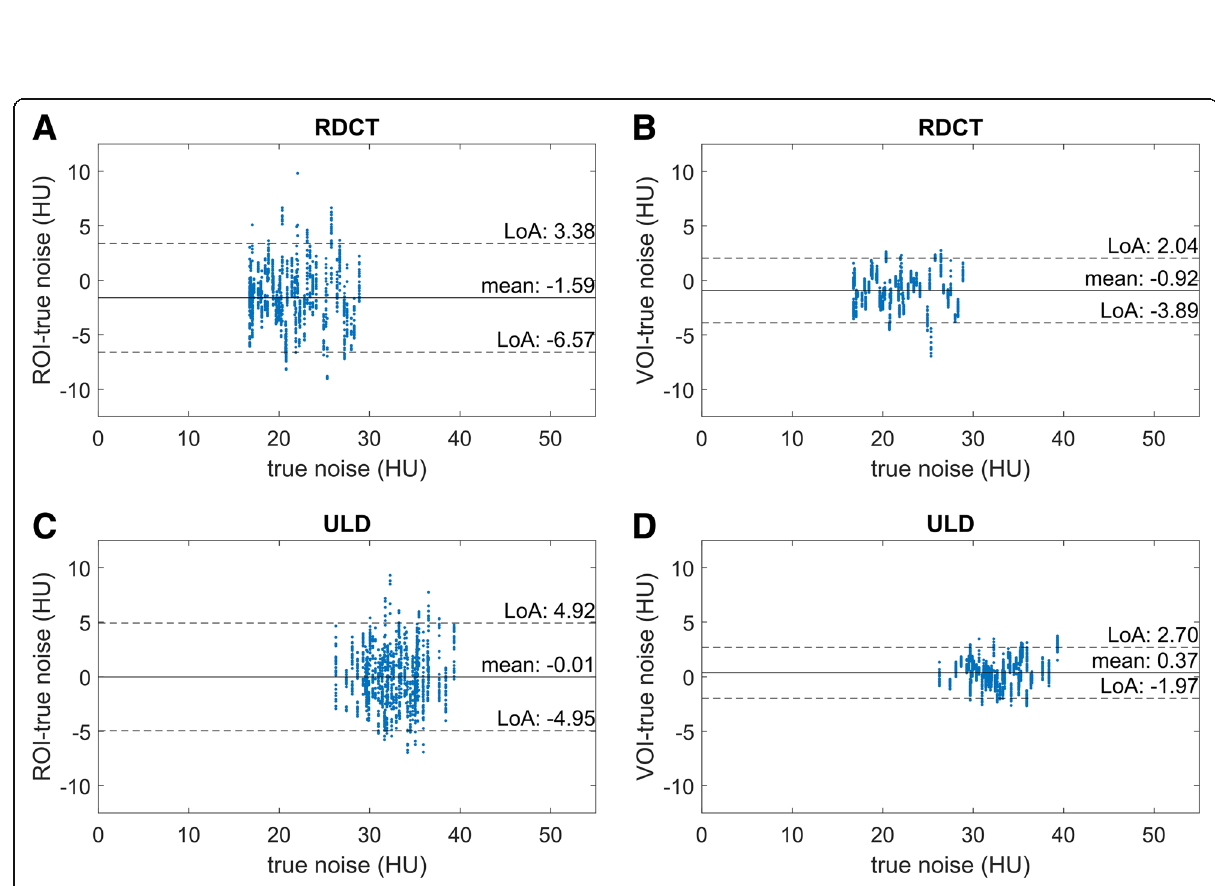
Fig. 2 Subsection of the CT images around the carina (window width 1600 HU, window level − 700 HU). The red part is the position of the region of interest, the blue is the volume of interest, the yellow is used to measure the ground truth, and the green area was removed from the segmentation to prevent edge artifacts like the partial volume effect. This image shows the measurement with the isocenter 1.0 cm above the carina ridge. a Axial images. b Coronal images, interpolated to account for the anisotropic dimensions of the voxels. c Volume render of the yellow segmentation